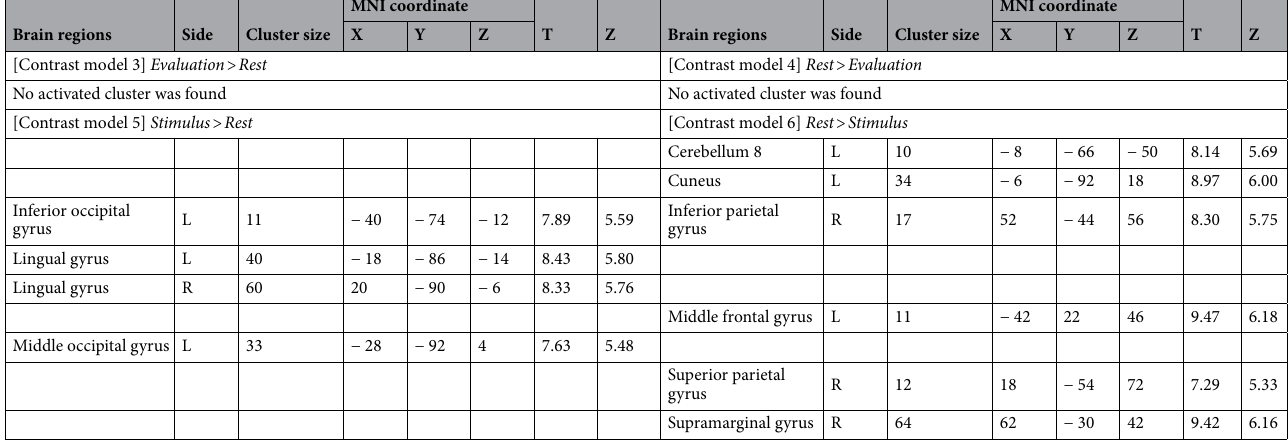
Table 2. MNI coordinates of results for contrast model 3, 4, 5, and 6. Row orders was sorted in alphabetical order with a few vacant rows to maximally visualize difference of two contrast models.